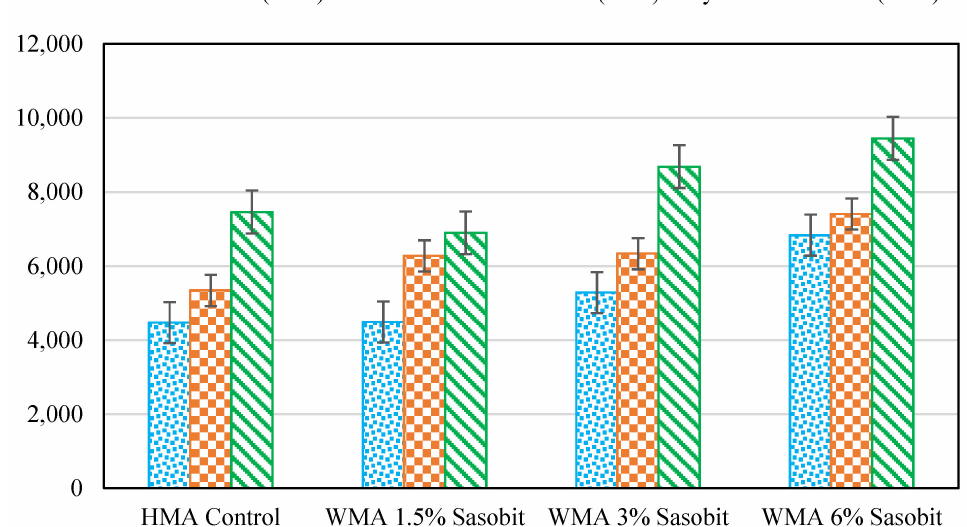
Figure 13. Comparison moduli at 20 ◦ C and 10 Hz loading